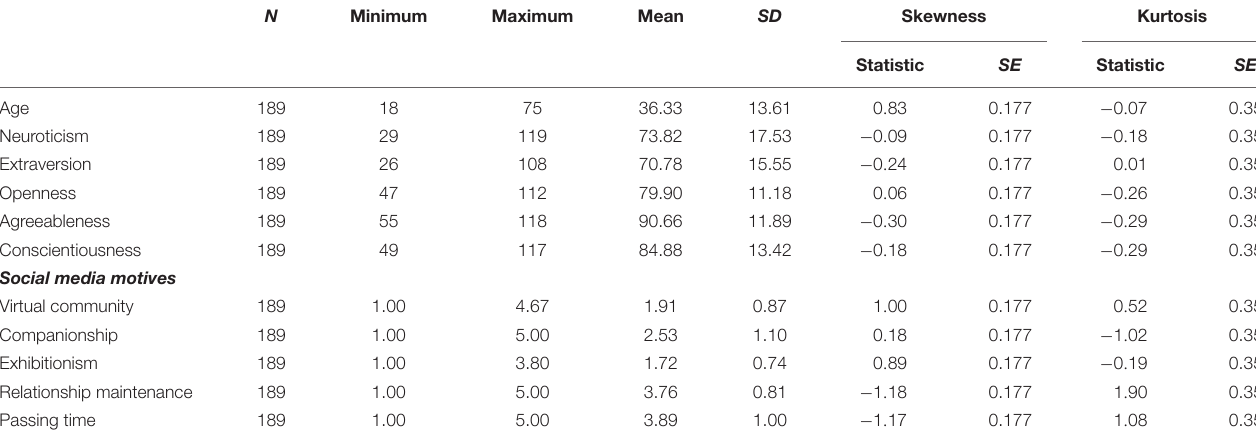
TABLE 1 | Means, standard deviations, skewness and kurtosis for all study variables. N Minimum Maximum Mean SD